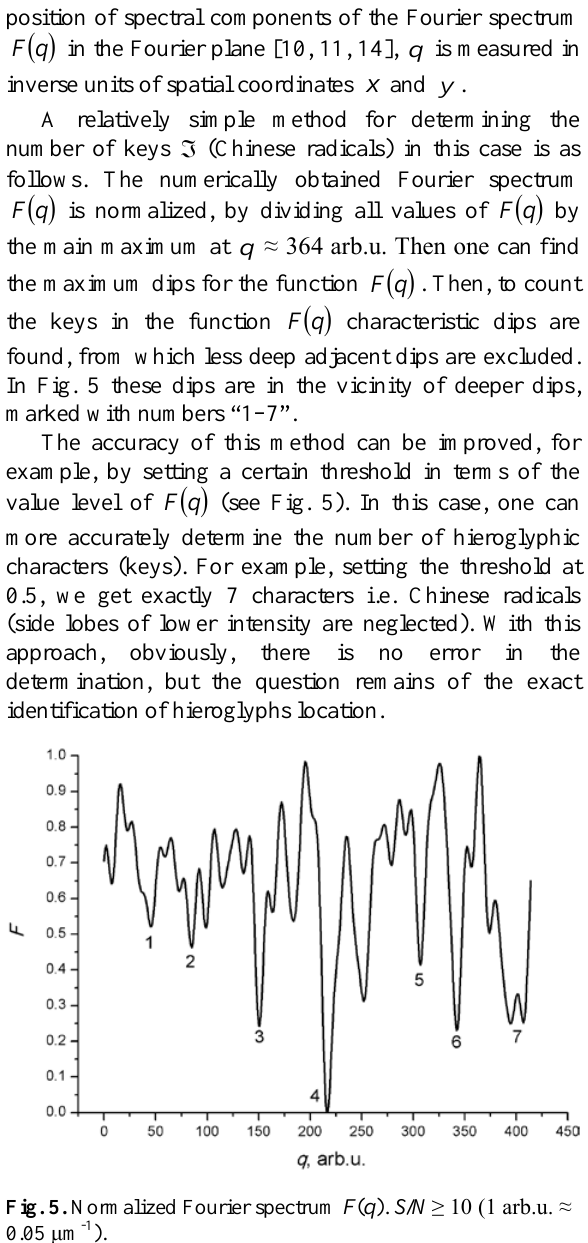
Fig. 4. Photo of the test sample, which shows 11 structural elements of the groove type (numbers from “1” to “11”).